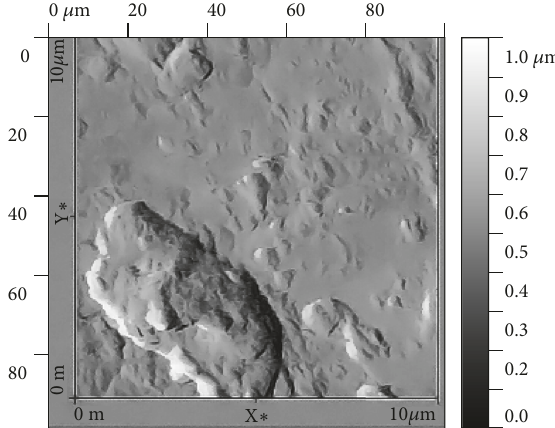
Figure 10: Image of a graphene oxide flake via SHOCON contact probe, taken prior to mixing into a solution to be reduced by the LightScribe. This is the only image taken of a graphene oxide flake that did not come purchased in premade solution.